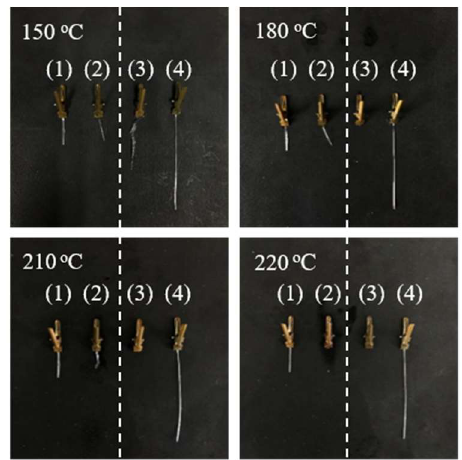
Figure 8. Appearance of PLA fibers. ( 1 ) PLLA/PDLA-60-2-210 fibers (original length 1.1 cm), ( 2 ) PLLA/PDLA-60-2-210 fibers (heated at different temperatures), ( 3 ) PLLA-130 fibers (heated at different temperatures), ( 4 ) PLLA-130 fibers (original length 4.3 cm).